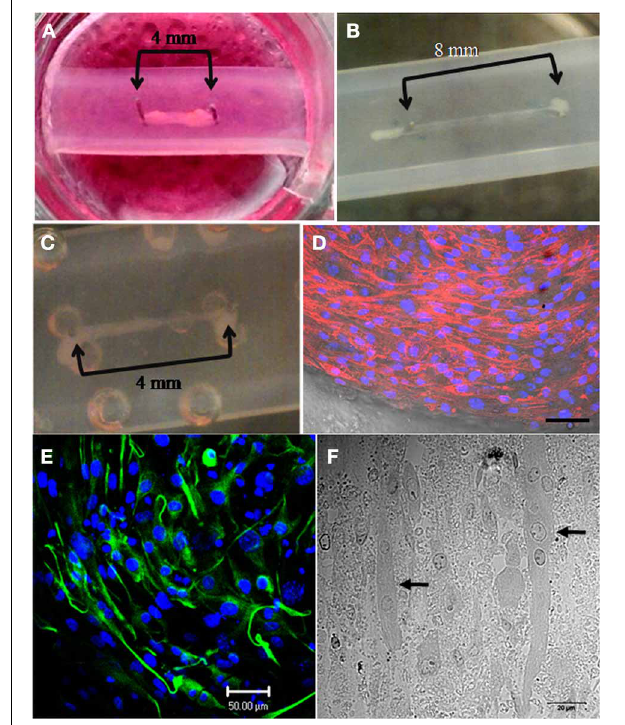
FIGURE 2 | Successful generation of mouse and human skeletal muscle constructs using the simple silicone chamber system. (A) When seeded in a matrix of collagen 1 and Matrigel (14%), mouse C2C12 cells formed tissue (day 7 in differentiation media) between pins placed 4mm apart. (B) When seeded in a matrix of collagen 1 and Matrigel (14%), mouse C2C12 cells formed tissue (day 3 in differentiation media) between pins placed 8mm apart. (C) When seeded in a matrix of collagen 1 and Matrigel (14%), human skeletal muscle (HSKM) cells formed tissue (day 3 in differentiation media) between pins placed 4mm apart. (D) After 12 days in differentiation media, actin fibers stained with TRITC-phalloidin and were clearly visible in the differentiated mouse C2C12 myotubes. Nuclei were stained with Hoechst (scale bar = 50 µ m). (E) After 15 days in differentiation media, elongated myotubes were aligned and contained desmin, an intermediate filament required for myotube contractile function (scale bar = 50 µ m). (F) Thin sections of resin-embedded C2C12 myoblasts culture for 15 days in differentiation media showed the formation of multi-nucleated (arrows) myotubes (scale bar = 20 µ